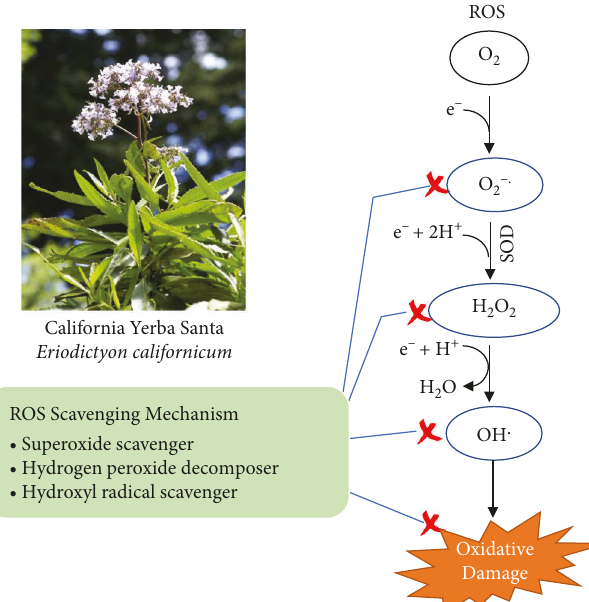
Figure 3: Role of E. californicum in the prevention of ROS-induced oxidative stress. ROS are highly reactive chemicals formed from O univalent reduction of molecular oxygen (O 2 ) produces superoxide radicals (O 2 • ‒ ), hydrogen peroxide (H 2 O 2 ), and hydroxyl radicals (HO • ). ECE scavenged superoxide and the hydroxyl radical and decomposed hydrogen